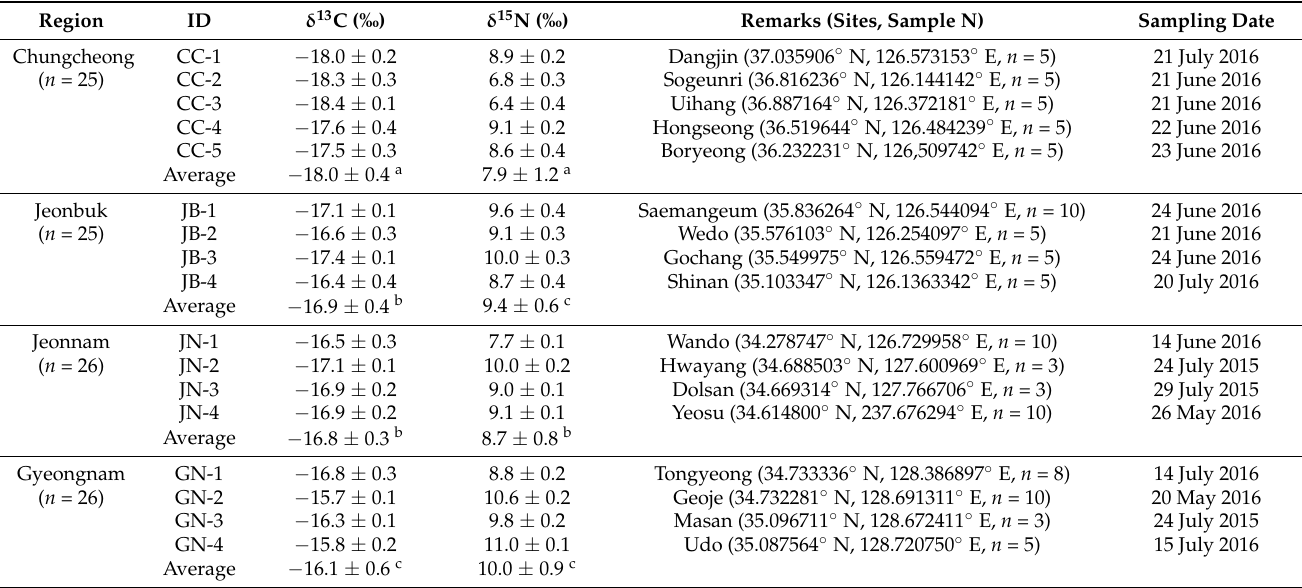
Table 1. Isotopic values ( δ 13C, and δ 15N) of the Manila clam Ruditapes philippinarum from various provinces of Korea. Different letters indicate significant differences with respect to regions (ANOVA, Tukey’s, p <